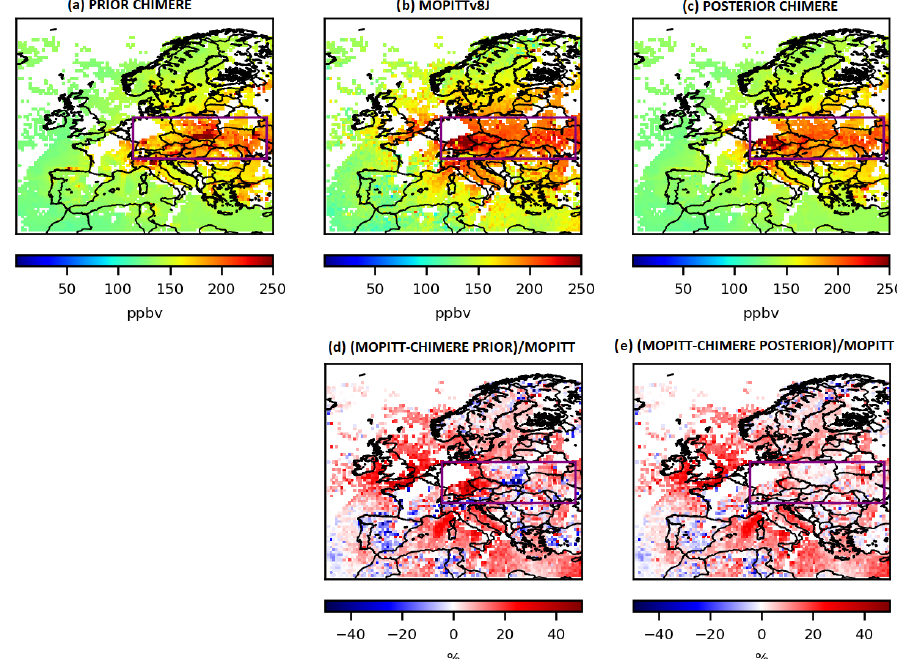
Figure 5. Mean CO collocated surface concentrations from 1 to 7 March 2015 (a) simulated by CHIMERE using the prior TNO-GHGco- v1 emissions and the climatological values from the LMDZ-INCA global model for initial and boundary conditions, (b) observed by MOPITTv8-NIR-TIR and (c) simulated by CHIMERE using the posterior emissions, in ppbv, at the 0.5 ◦ × 0.5 ◦ grid-cell resolution. Relative differences between MOPITT and (d) the prior CHIMERE simulation or (e) the posterior CHIMERE simulation, in %. Statistics for the comparison between simulations and observations are given in Table 4 for the area in the purple